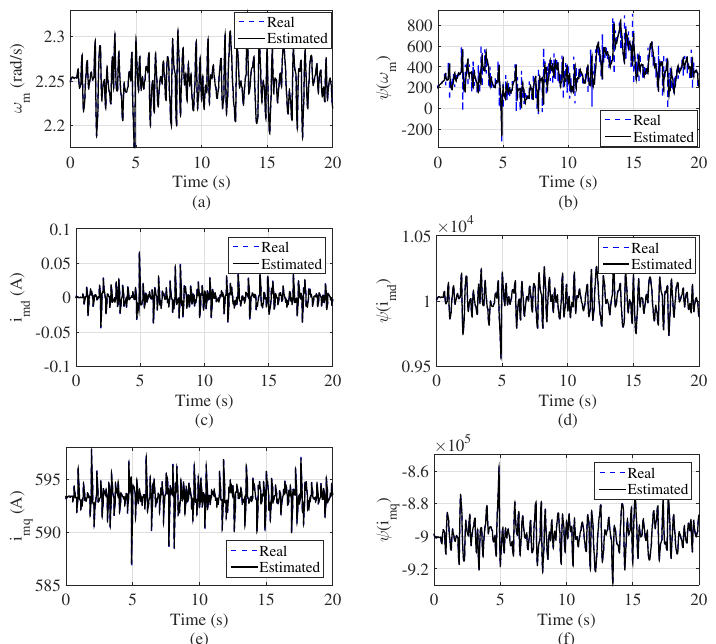
Figure 8. Estimations of states and perturbations. ( a ) Estimation of mechanical rotation speed ω m . ( b ) Estimation of perturbation term Ψ 1 . ( c ) Estimation of i md . ( d ) Estimation of perturbation term Ψ 2 . ( e ) Estimation of i mq . ( f ) Estimation of perturbation term Ψ 3